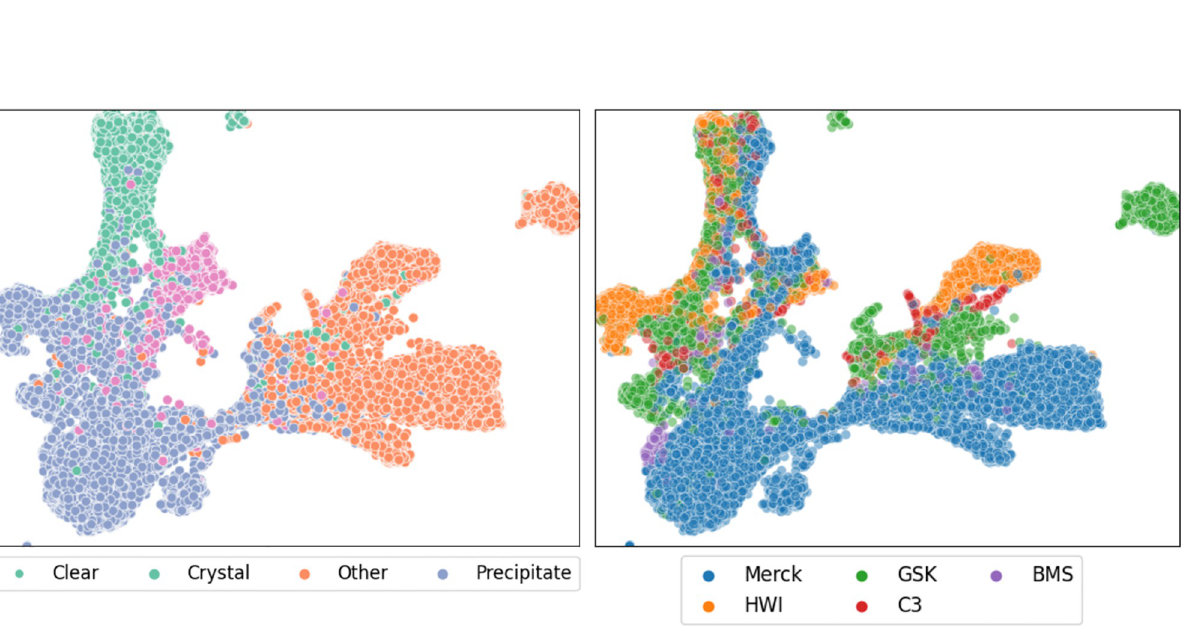
Fig 6. UMAP projection of labelled data from the MARCO validation dataset. The left hand figure shows the projection from the ResNet 50 model coloured by classification, where clear, crystal, other and precipitate are coloured green, pink, blue and orange respectively. The right hand figure shows the same projection, but coloured by source of the images—Merck, GSK, BMS, HWI and C3 are coloured blue, green, purple, orange and red respectively. A similar UMAP projection using the original Inception V3 model from 2017 is shown in S1 Fig in S3 Appendix.